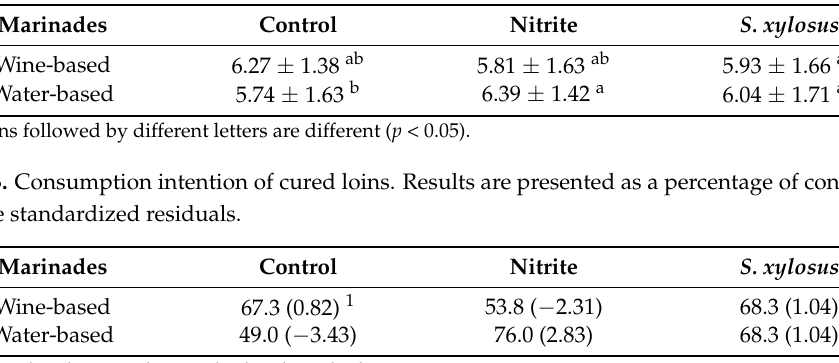
Table 4. Mean drop (MD) and penalties associated with a non-ideal evaluation of the cured loins’ color. Marinades